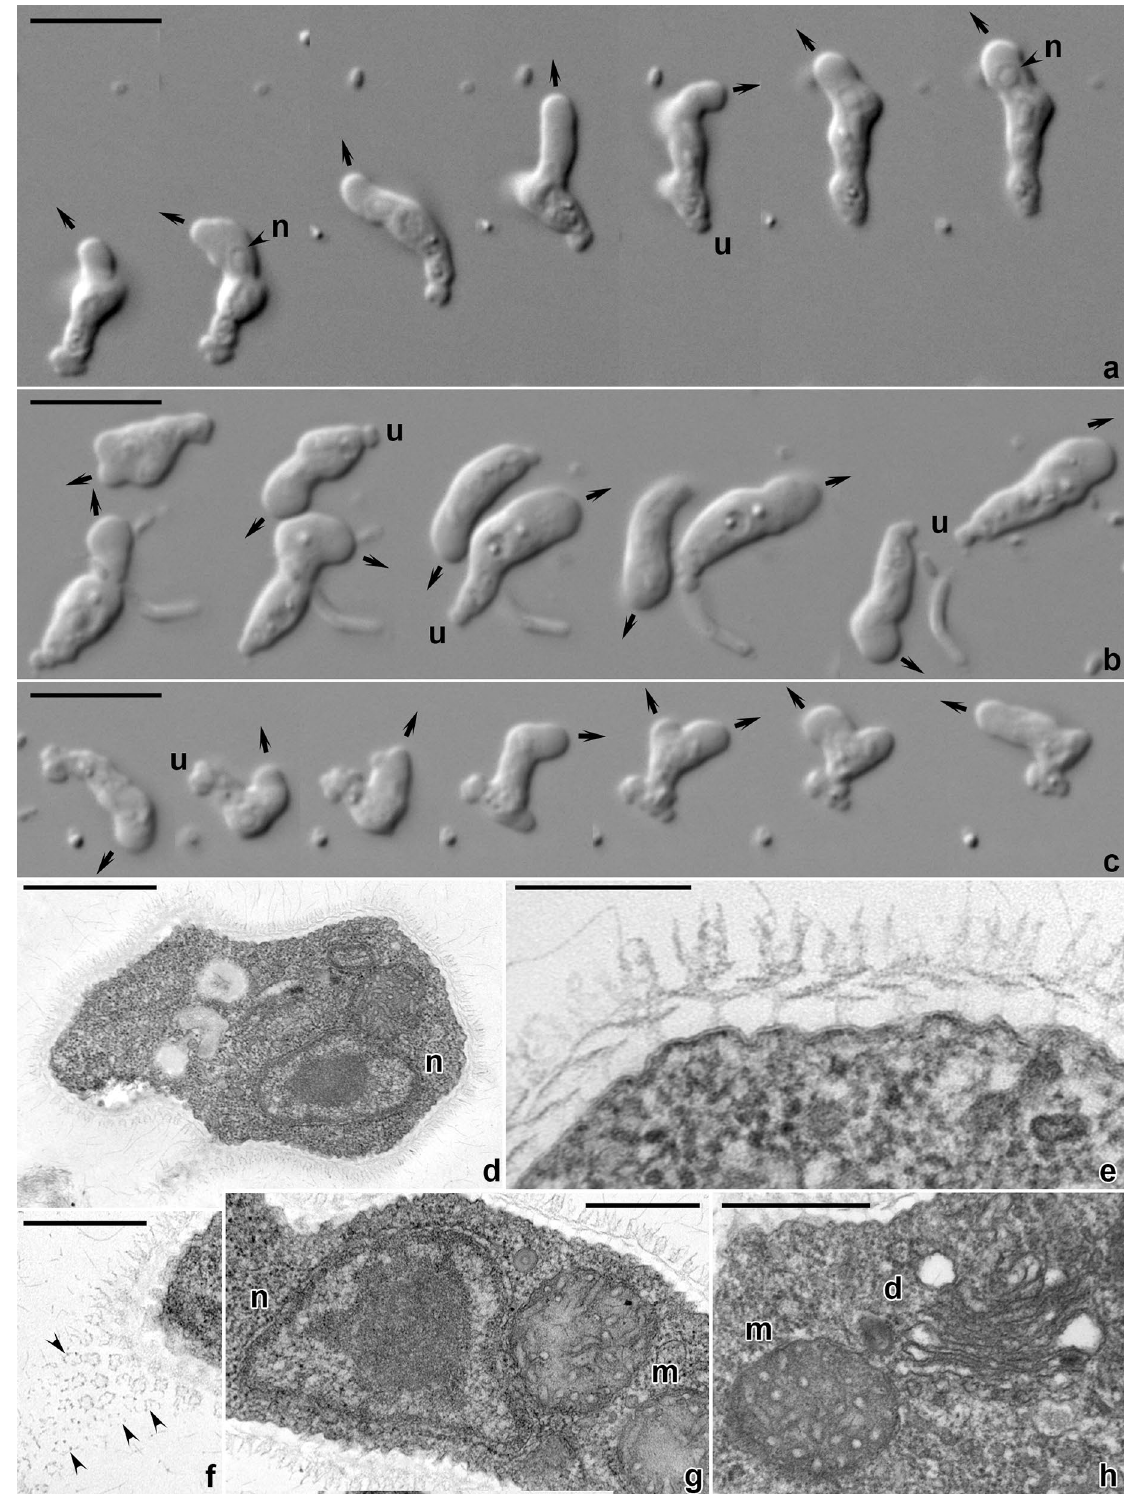
Figure 1. Morphology of Coronamoeba villafranca gen. nov. sp. nov. Light ( a – c ) and transmission electron microscopic (TEM) images ( d – h ). ( a – c ) Time-lapse sequences of the locomotion of amoebae ( a , c show movement of one cell each; b simultaneous movement of two cells), DIC. Arrows indicate direction of advancement of the anterior end. ( d ) Low magnification TEM image of the whole cell. ( e ) Cell coat in a vertical section. ( f ) Cell coat elements in a tangential section (arrowheads). ( g ) Nucleus and a mitochondrion. ( h ) Dictyosome and a mitochondrion. d dictyosome, m mitochondria, n nucleus, u uroid. Scale bar 10 µm in ( a – c ), 1 µm in ( d ), 0.5 µm in ( f – h ), 0.2 µm in ( e